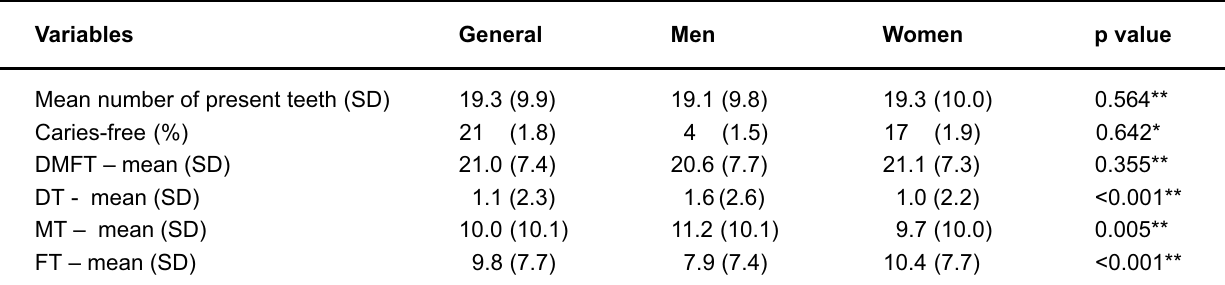
TABLE 2- Mean number of present teeth and caries experience among subjects (general) and according to gender (men and women). Southeastern state of São Paulo, Brazil